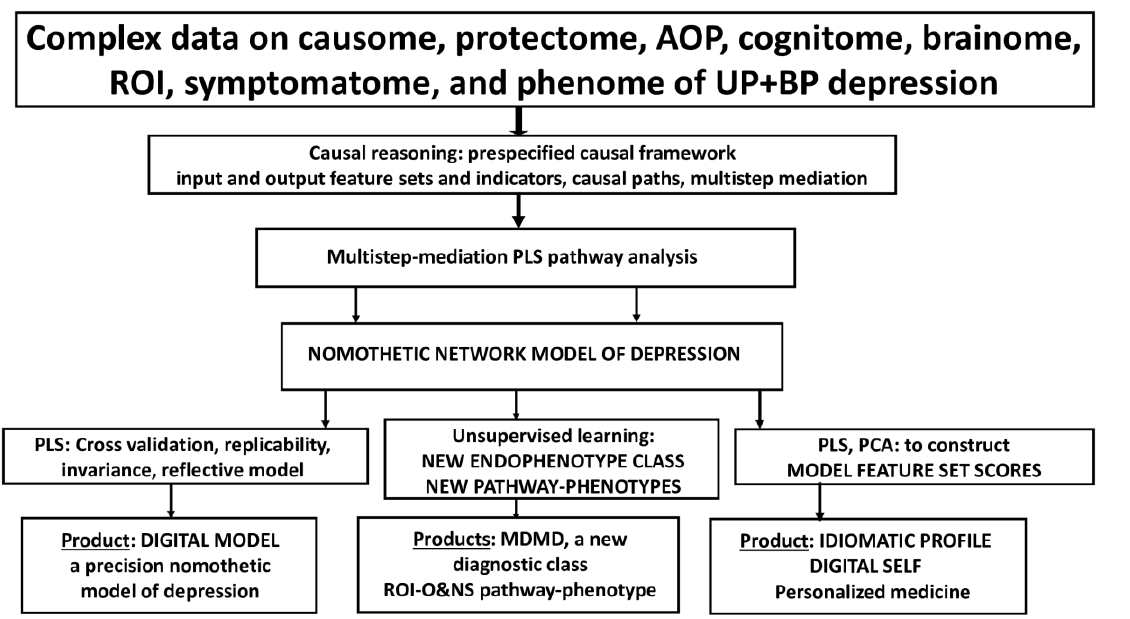
Figure 6. The major steps in precision medicine as applied in precision nomothetic psychiatry for constructing a new model of depression, new endophenotypes including major dysmood disorder (MDMD), and an idiomatic profile. ROI-O&NS: a pathway phenotype comprising staging of mood disorders and oxidative and nitrosative stress biomarkers.